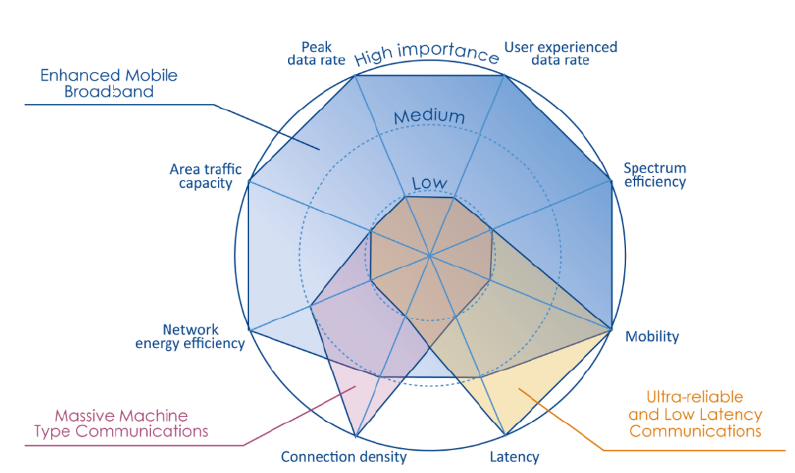
Figure 4. The expected requirements for 5G application-types